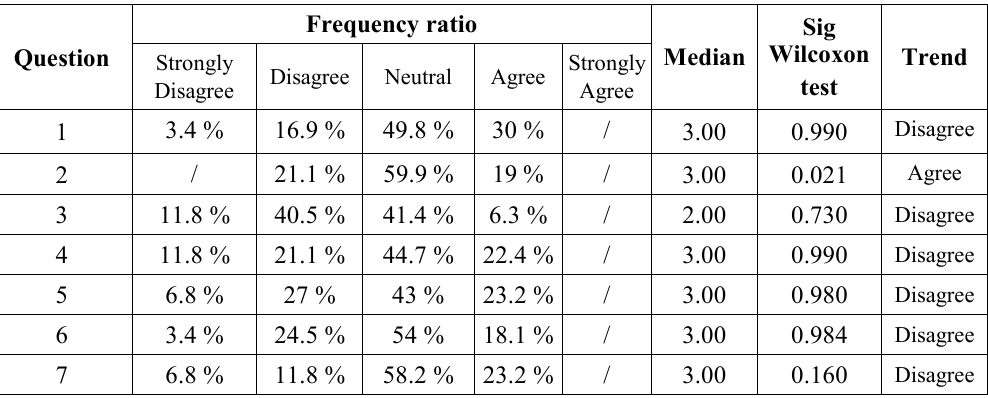
Table 6. Results of the Second